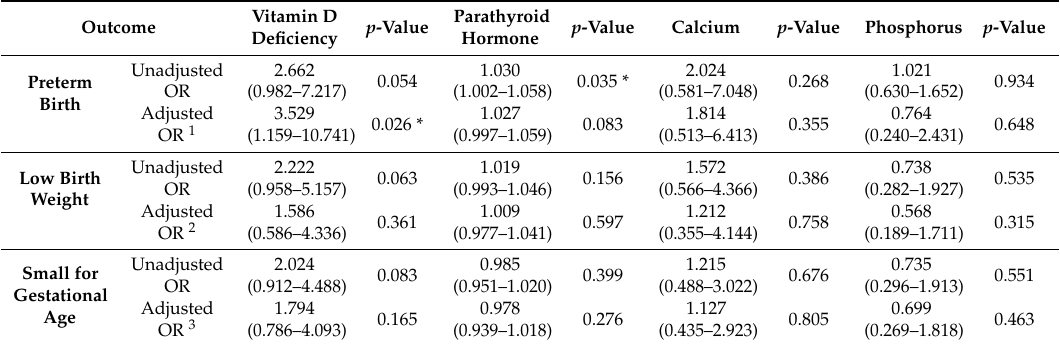
Table 4. Associations between Vitamin D deficiency, parathyroid hormone (PTH), calcium, phosphorus, and adverse perinatal outcomes in the cohort of